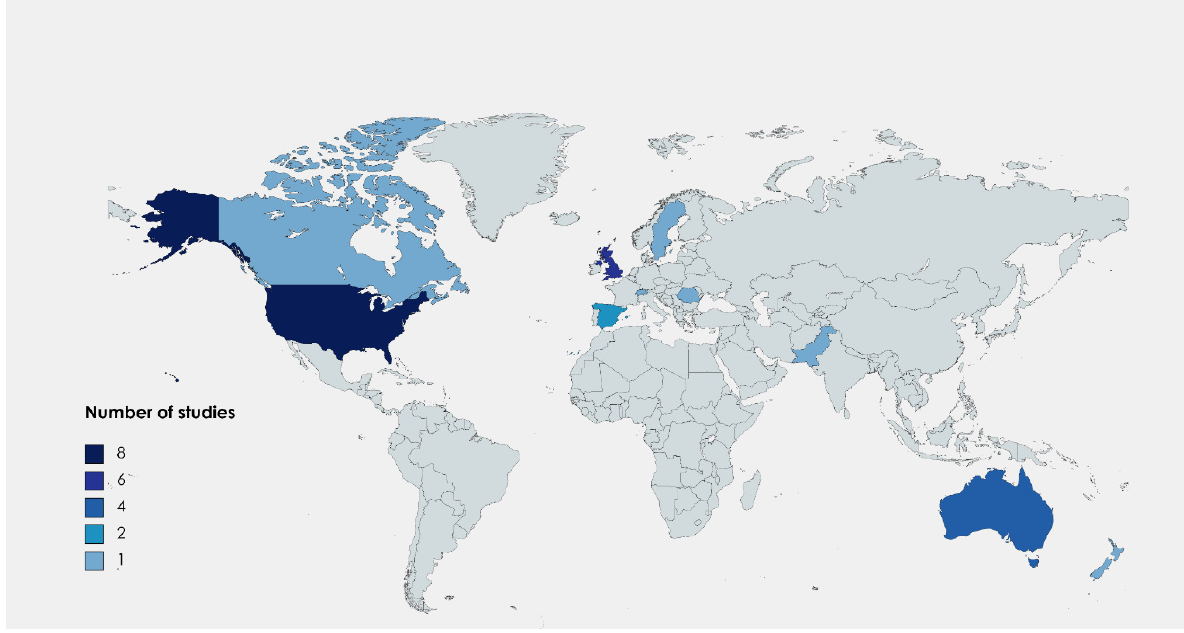
Figure 2. Map of included studies.